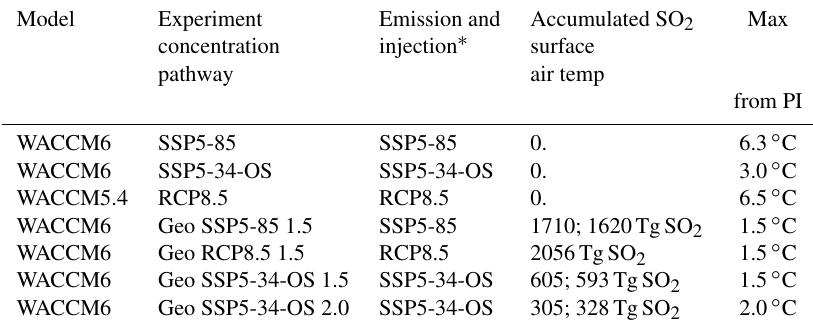
Table 1. Overview of model simulations.